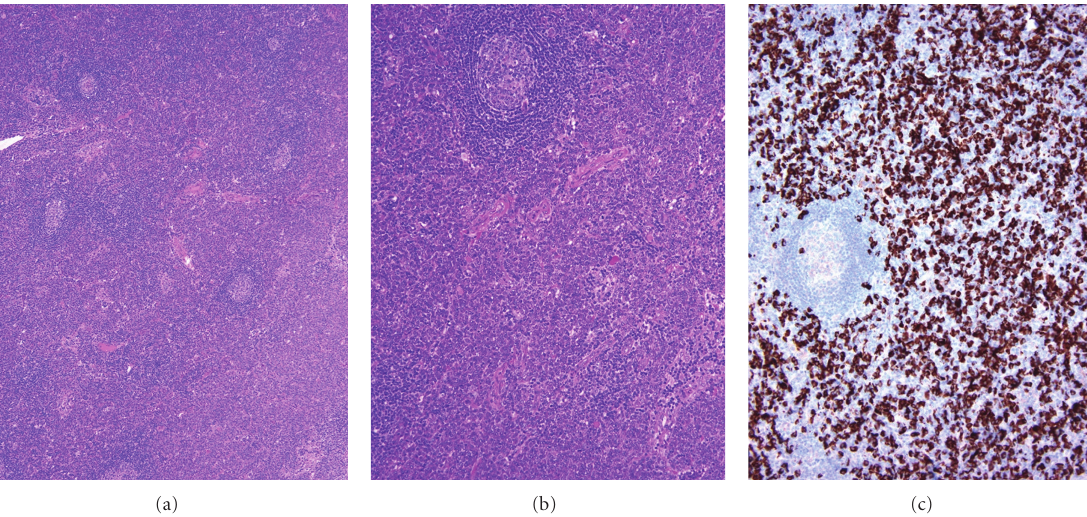
Figure 6: Multicentric Castleman’s disease with abundant IgG4 + cells. (a) Atrophic germinal centers and interfollicular expansion are seen. (b) Sheets of proliferating mature plasma cells are present in the interfollicular zone. (c) The majority of mature plasma cells are positive for IgG4 (IgG4 + /IgG + plasma cell ratio >